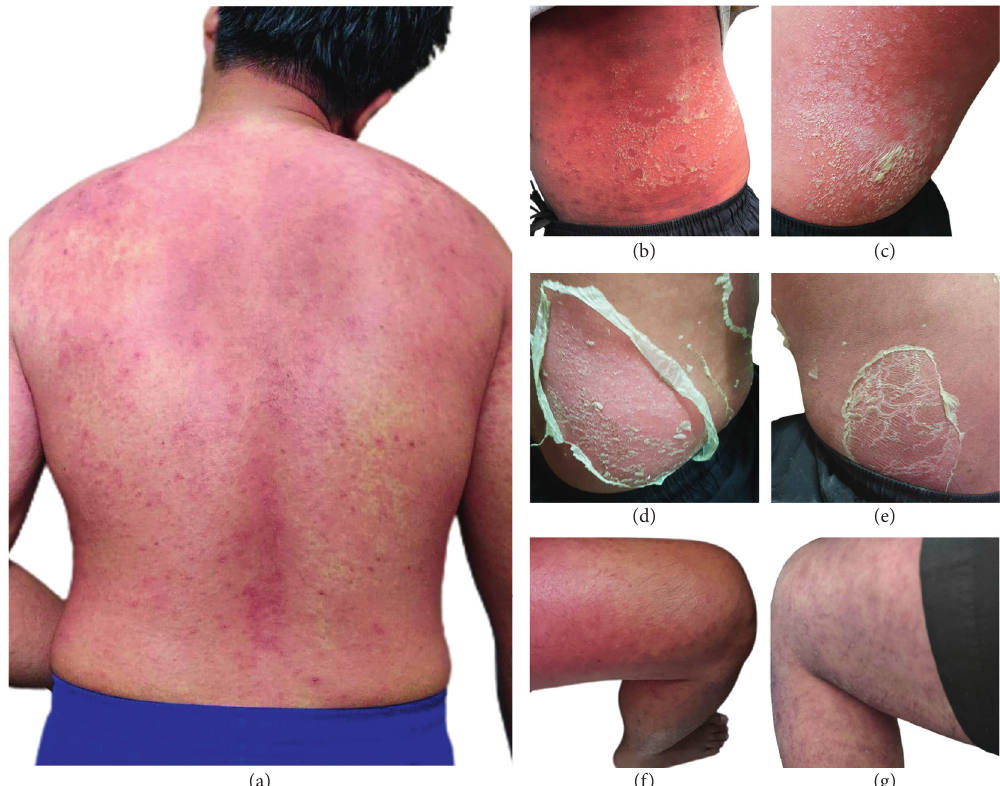
Figure 2: Generalized erythroderma with desquamation and scaling was shown around the (a) back, (b–e) body, and (f, g) legs of the patient at day 5 of